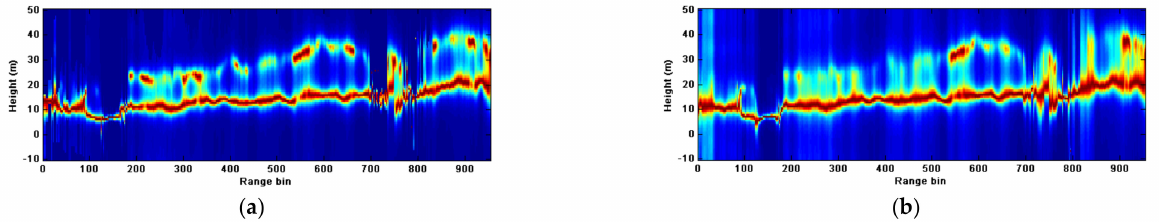
Figure 8. ( a ) Tomogram from Differential Tomography. Data from BioSAR 1, Remningstorp. ( b ) Corresponding tomogram from plain